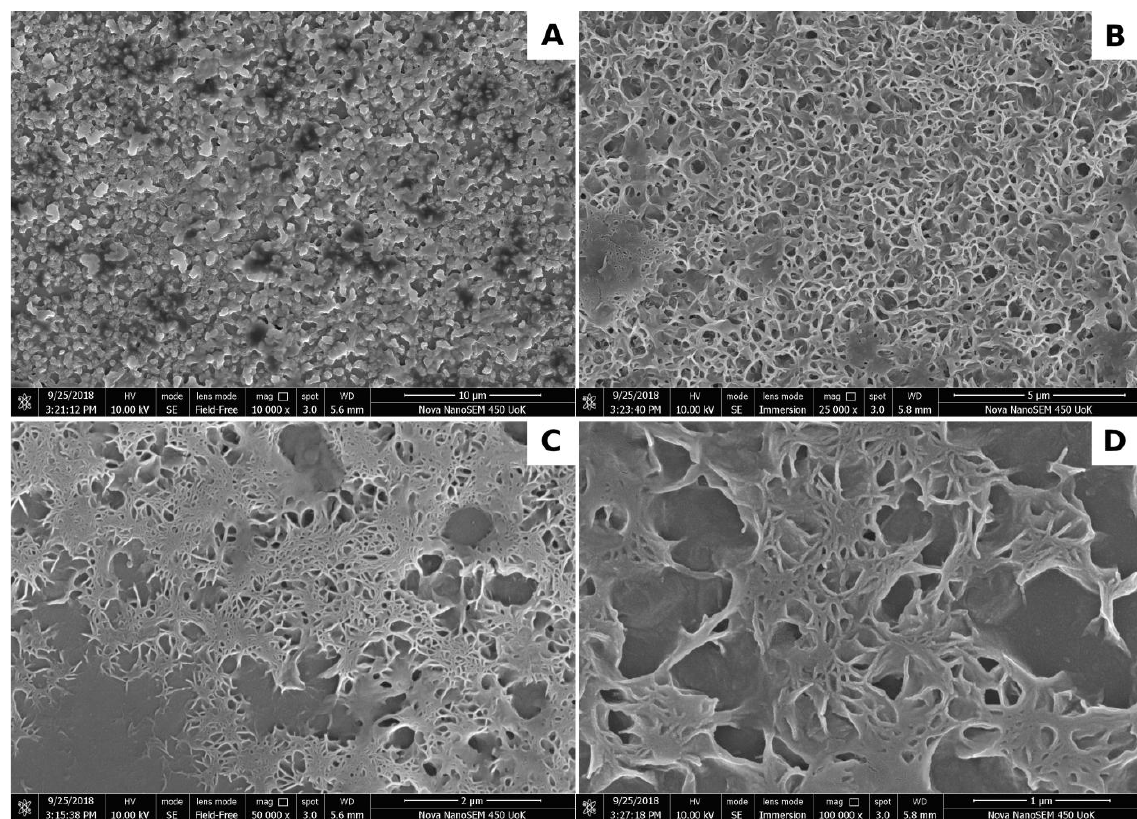
Figure 2. FESEM images of ZnO nanoparticles at various magnifications ( A ) 10,000× ( B ) 25,000× ( C ) 50,000× ( D ) 100,000×.